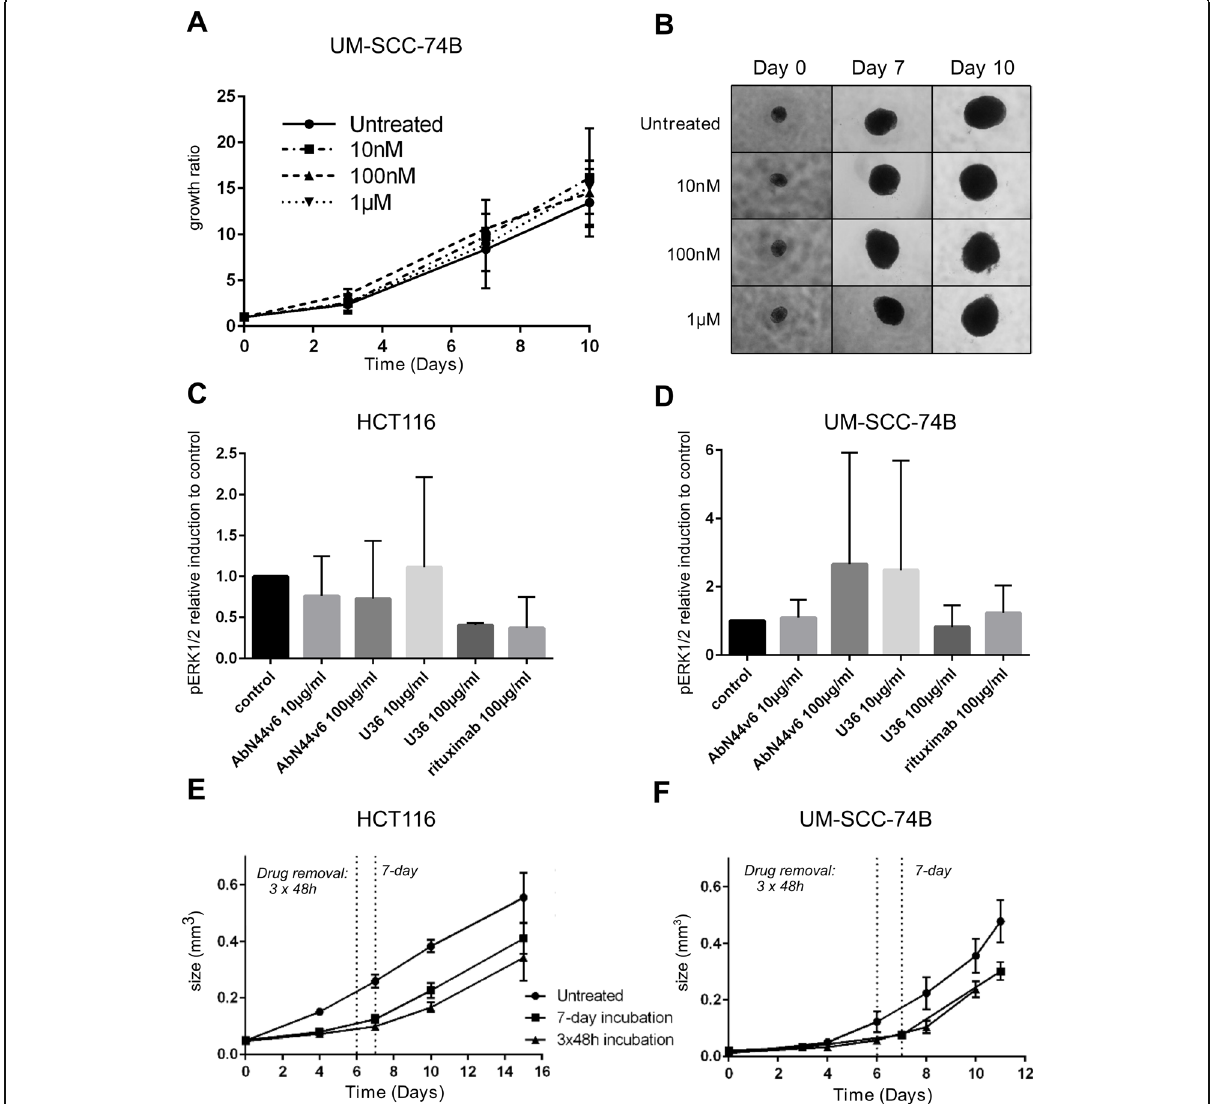
Fig. 2 a Dose-response of AbN44v6 on UM-SCC-74B spheroids treated with AbN44v6 (untreated controls, 10 nM, 100 nM, 1 μ M) presented as growth ratios over time as well as b representative images of treated spheroids, n ≥ 4, error bars presented as 95% confidence intervals. c Relative pErk1/2 induction following FGF2 stimulation compared to control of HCT116 samples. d Relative pErk1/2 induction following FGF2 stimulation compared to control of UM-SCC-74B samples, n = 3, error bars presented as SD. e Growth inhibitory effects of PM2 measured in spheroid volume (mm 3 ) using two different treatment regimens on HCT116 spheroids and f UM-SCC-74B spheroids. n ≥ 5, error bars presented as